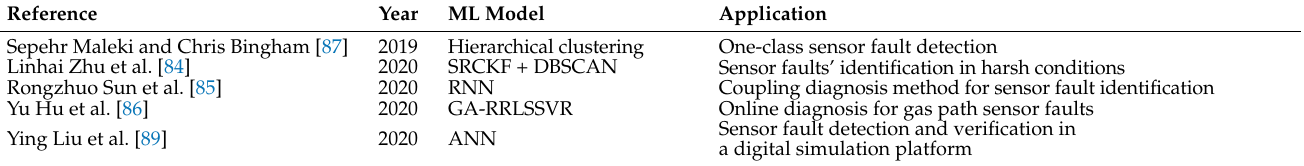
Table 4. Summary of the presented methods for sensor fault identification using machine-learning models